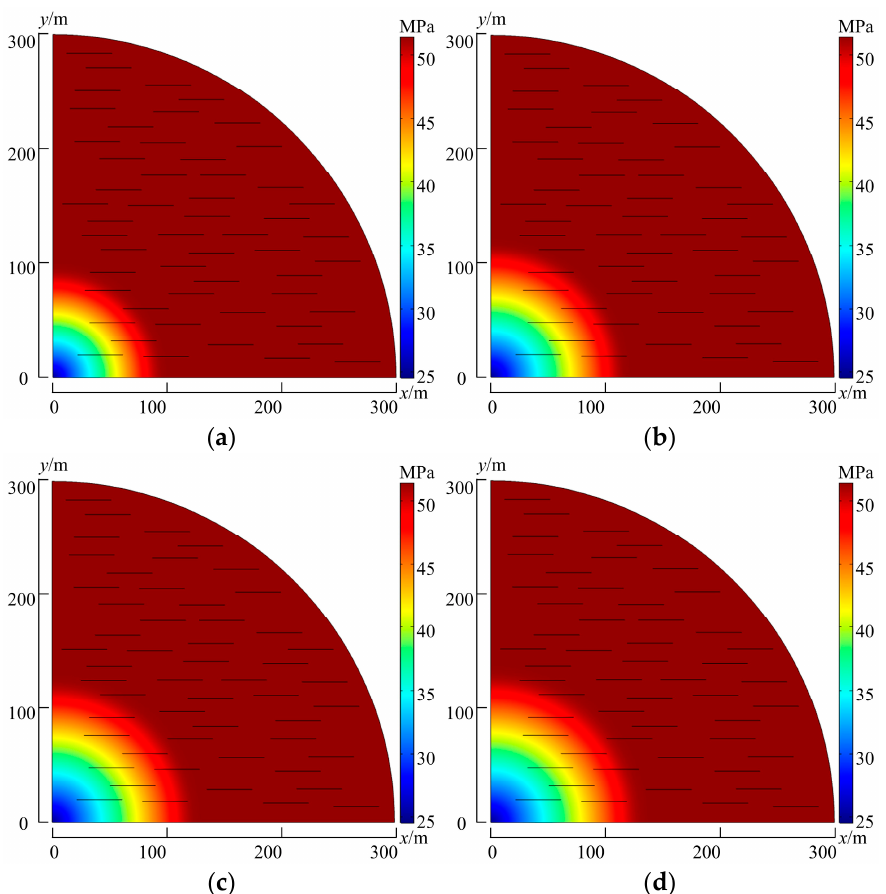
Figure 7. Formation pressure distribution at different times. ( a ) 500 d, ( b ) 1000 d, ( c ) 1250 d, ( d ) 1500 d.